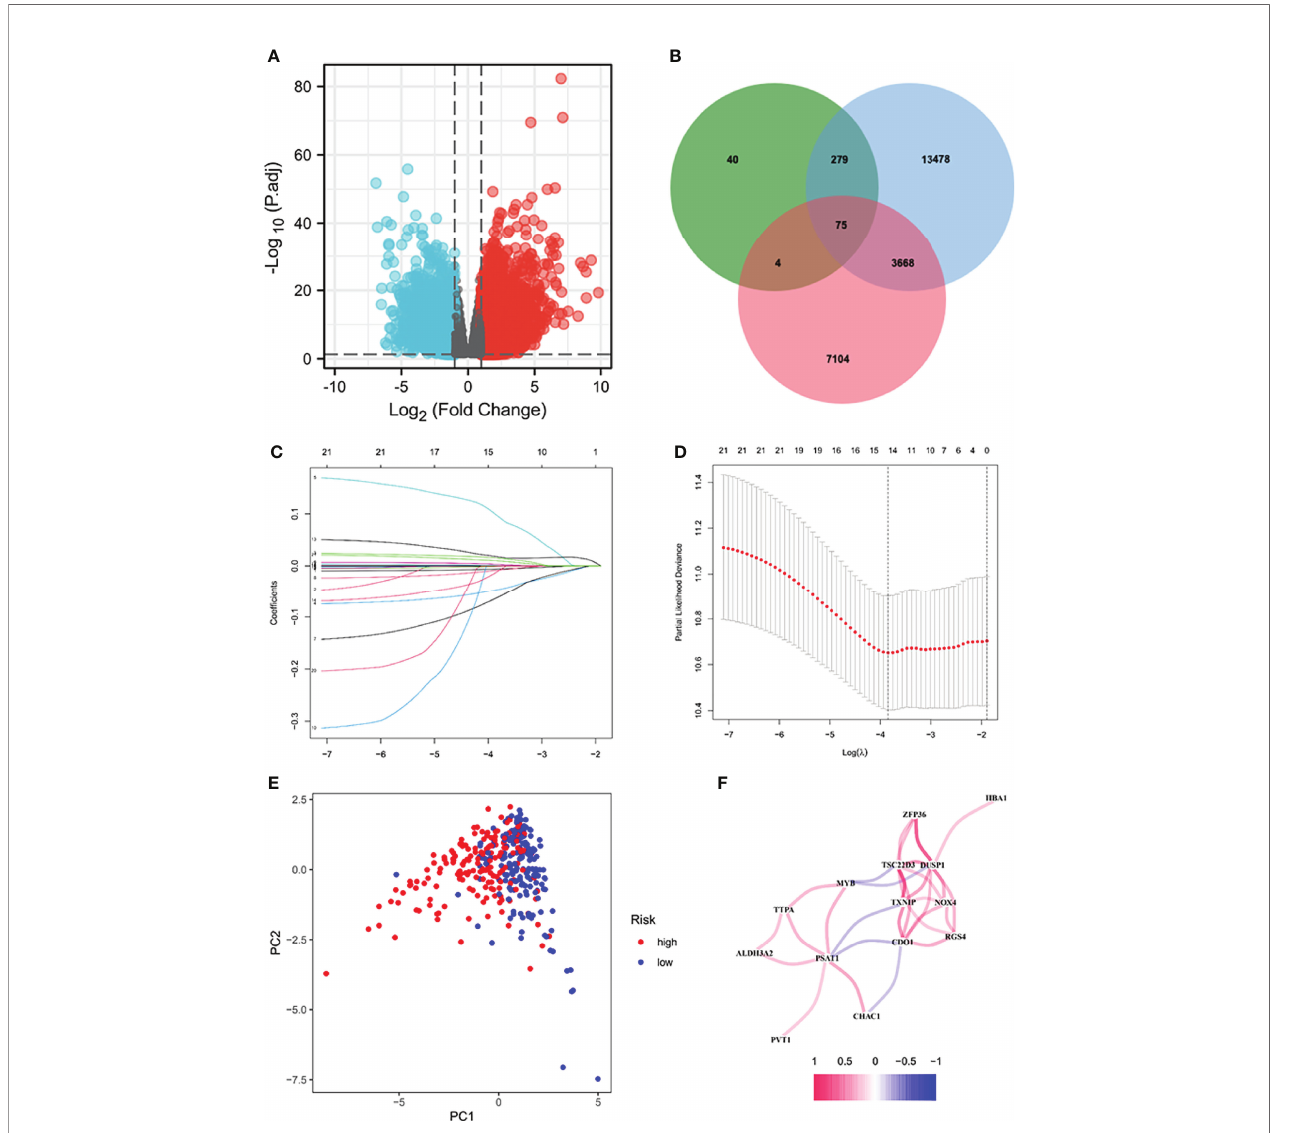
FIGURE 1 | Screening for differentially expressed genes. Volcanic diagram of differentially expressed genes (DEG) between normal gastric tissue and gastric cancer (A) . Red represents up-regulated genes and blue represents down-regulated genes. According to three data sets (B) Venn diagram showing 75 immune ferropotosis genes. LASSO regression analysis of 75 DEGs. Ten-fold cross-validation was applied to calculate the best lambda, which leads to a minimum mean cross-validated error (C) . A total of 15 DEHGs were adopted for the LASSO model (D) . (E) PCA diagram of high and low risk groups. (F) Correlation network diagram of prognostic model genes. PCA, principal component analysis; IRG, Human immunity-related genes; FRG, human ferropotosis-related